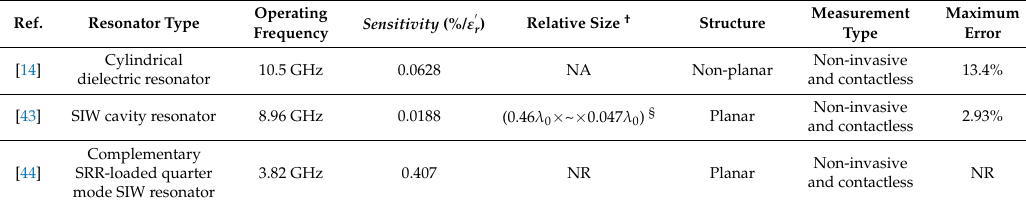
Figure 17. Plot of the sensitivity as a function of ε (cid:48) r Table 3. Comparison of other recently published works and this